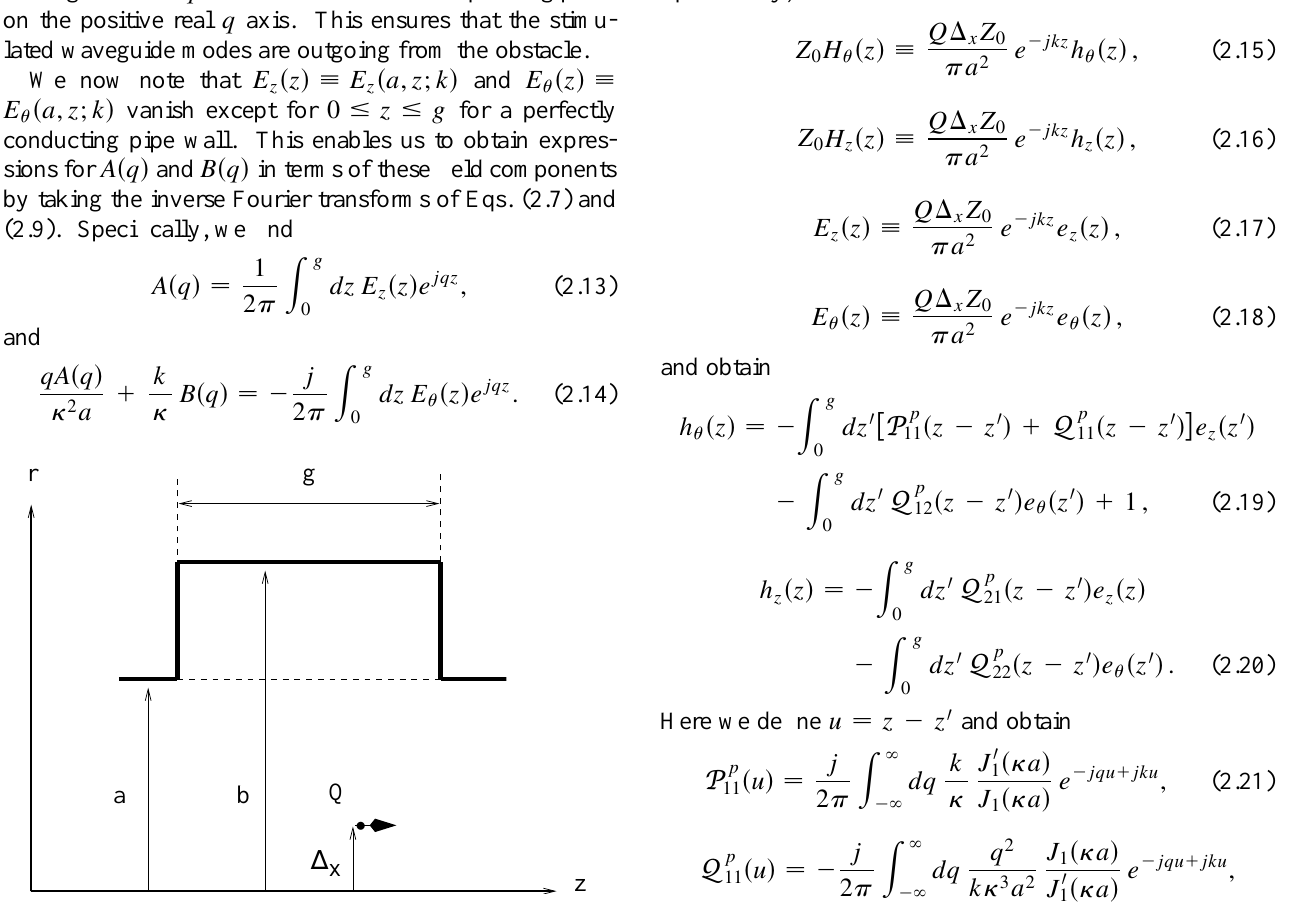
FIG. 1. The layout of geometry for a single